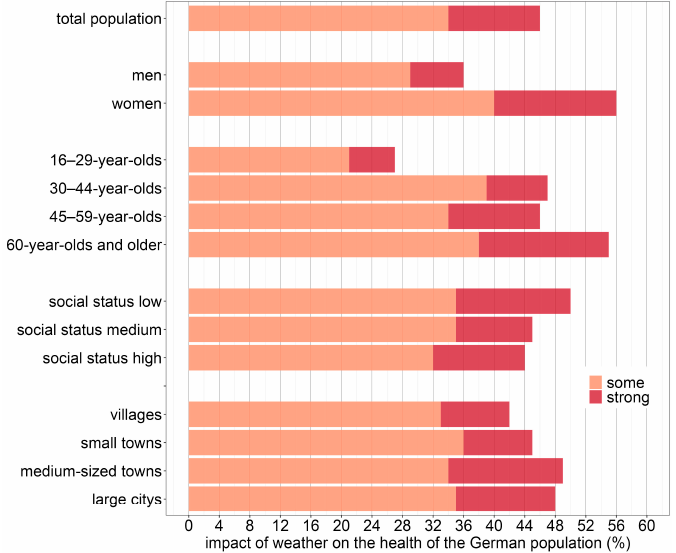
Figure A1. Differences in weather sensitivity between men and women as well as between the younger and older generation. A total of 27% of the 16–29-year-olds were sensitive to weather. In contrast, 54% of the older individuals were sensitive to weather. This is more frequent than the average.